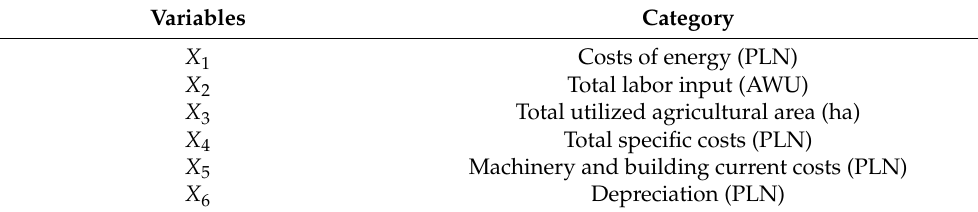
Table 2. The final set of diagnostic variables adopted for the classification of dairy